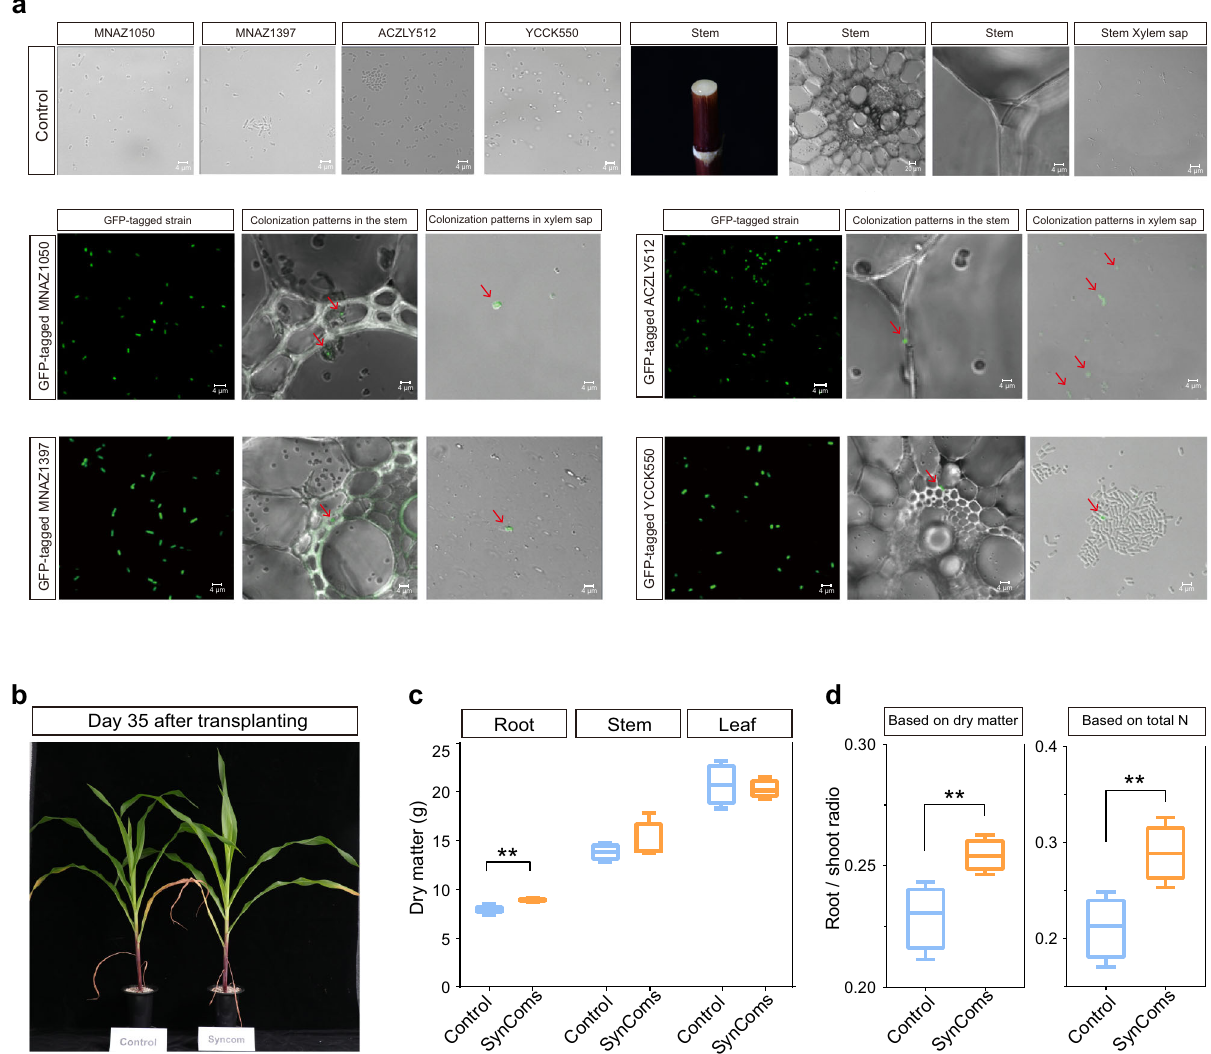
Fig. 5 Colonisation and nitrogen fi xation by SynComs in xylem of maize plants. a Potted plant experiment with GFP-tagged SynComs. SynComs with no GFP tags served as control. Images are confocal laser scanning microscopy (CLSM) micrographs. Four biological replicates showed the similar results. b , c , d Potted plant experiment with growth mixture containing 15 N. Growth pro fi le ( b ) at 35 days after transplanting after inoculation with control and SynComs, dry matter of root, stem and leaf ( c ), and root/shoot ratio ( d ) of maize plants at 65 days after transplanting after inoculation with control and SynComs. Horizontal bars within boxplot represent medians. Asterisk indicates a signi fi cant difference at P < 0.01. Boxplot displays the median and interquartile range. Upper and lower whiskers extend to data no more than 1.5× the interquartile range from upper and lower edge of the box, respectively. The statistical analyses were performed using a two-sided T-test ( n = 4). P values are indicated by *, i.e., ** represents p < 0.01. Source data are provided in the Source Data fi